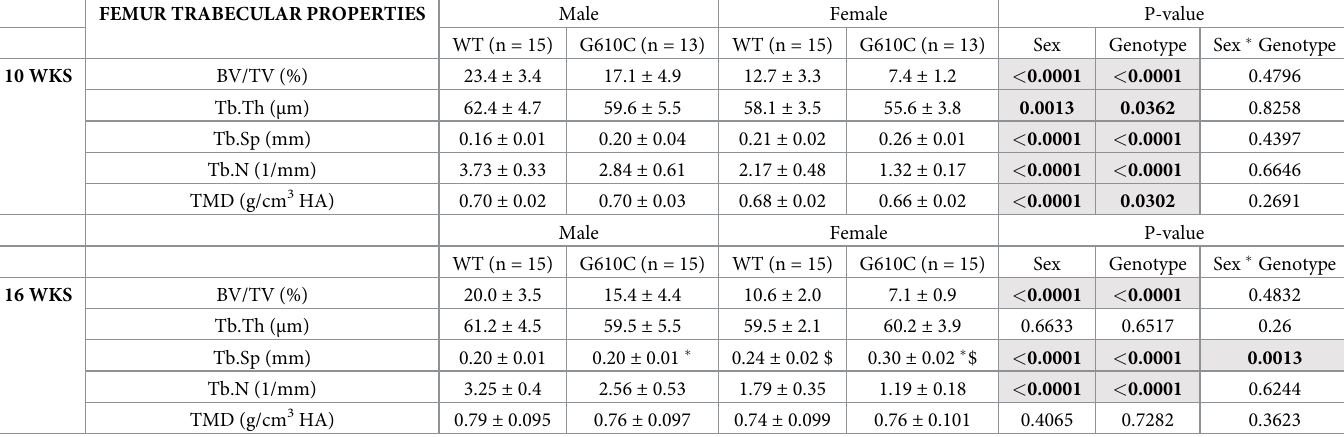
Table 5. Femur trabecular properties at 10 and 16 weeks, with p-values from 2-way ANOVA. FEMUR TRABECULAR PROPERTIES